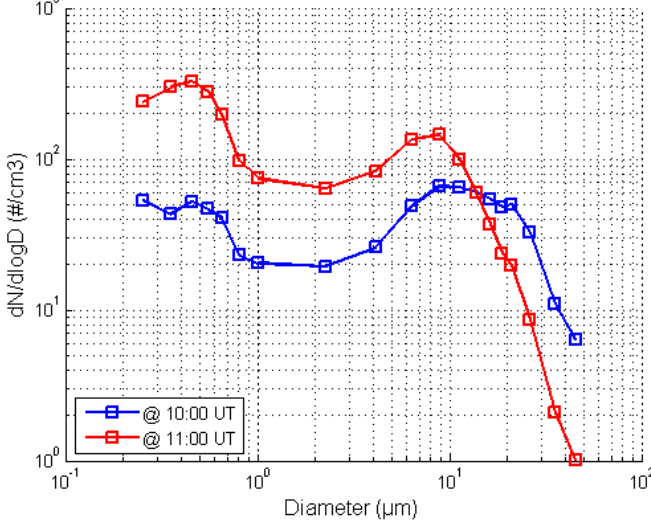
Figure 2. Particle-size distribution derived from LOAC sensor on 3 January 2017 at 10:00 and 11:00 UT.